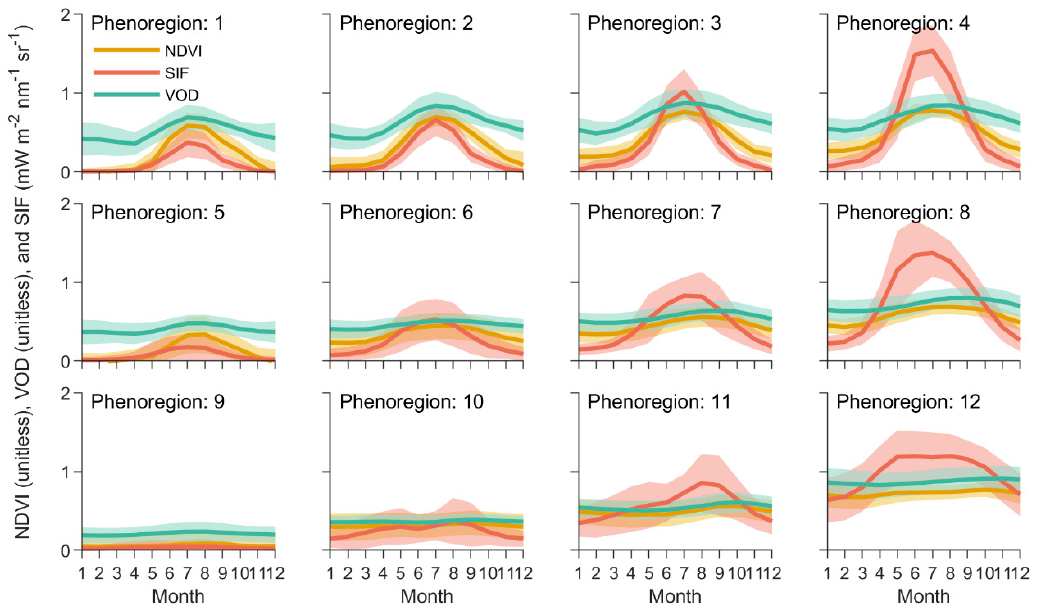
Figure 3. Mean seasonal cycles (±1 standard deviation) of each vegetation index within each of the 12 Level I phenoregions. To maintain consistent growing season timing across hemispheres, the seasonal cycles shown above start in January for the Northern Hemisphere and July for the Southern Hemisphere.